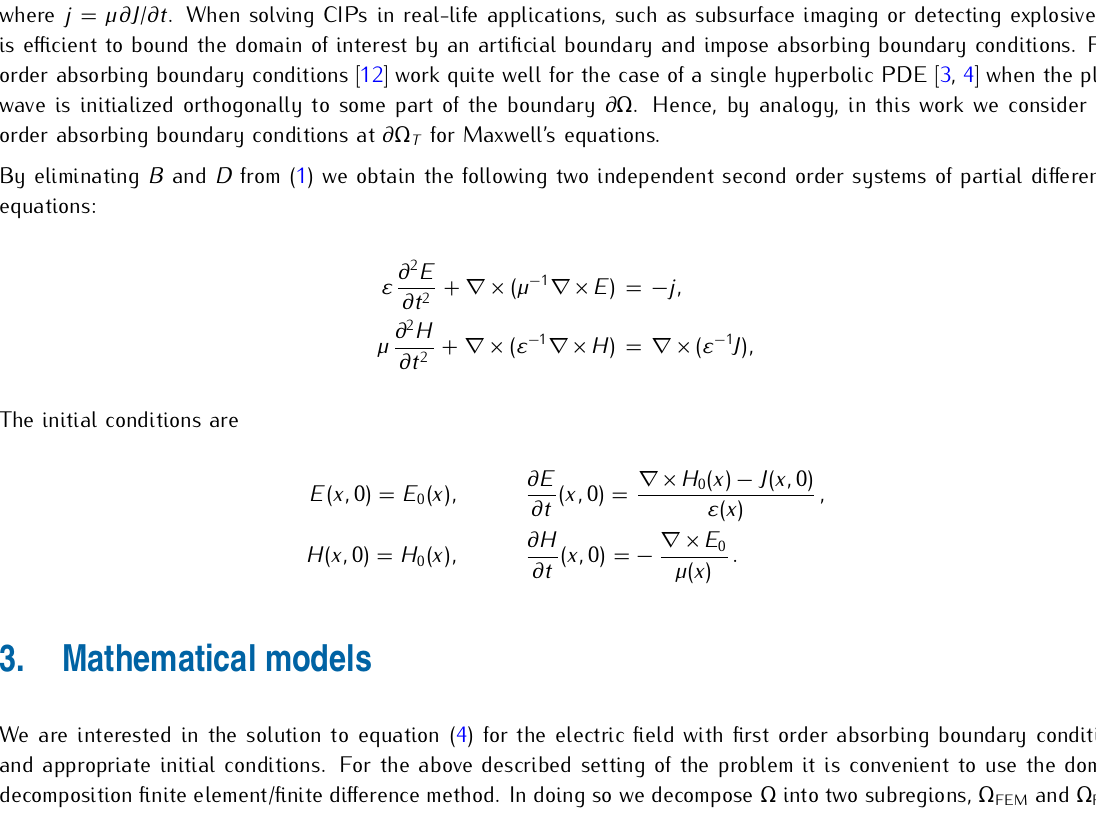
and Ω . The circles are FEM FDM . At each time iteration, the solution FEM at ω x is copied FEM